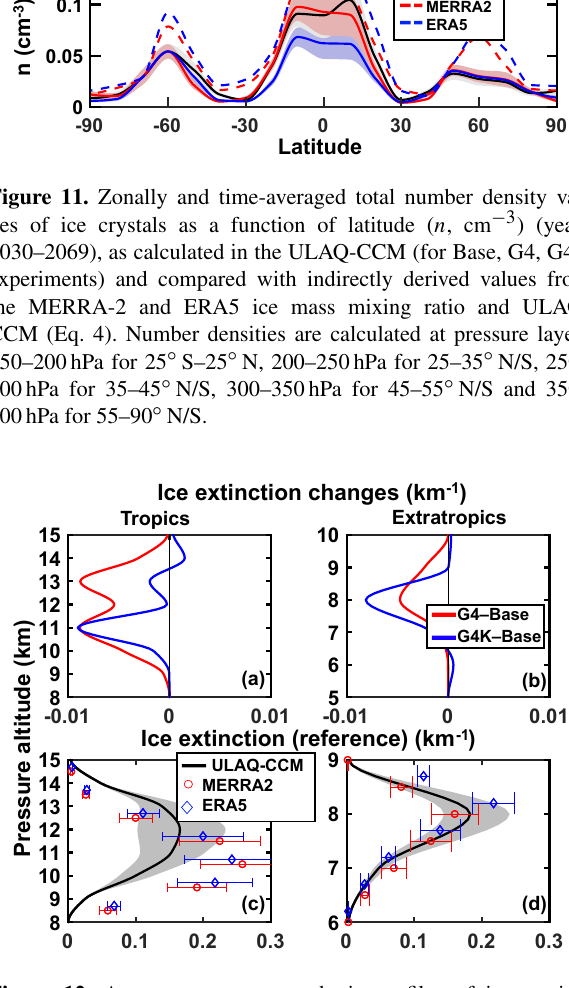
Figure 12. Average upper tropospheric profiles of ice particle extinction ( λ = 0 . 55µm) (km − 1 ) for the tropics (25 ◦ S–25 ◦ N) and extratropics (35–90 ◦ S, 35–90 ◦ N) in panels (a) and (c) and (b) and (d) , respectively. (a, b) Ice extinction changes for G4- Base (red curves) and G4K-Base (blue curves) (years 2030–2069). (c, d) Comparison of ULAQ-CCM calculated values of ice extinc- tion with indirectly derived values from the MERRA-2 and ERA5 ice mass mixing ratio and ULAQ-CCM effective radius (red and blue circles) (see text). The time average is over the years 2003– 2012. The shaded areas represent ± 1 σ for the ensemble over the 10-year